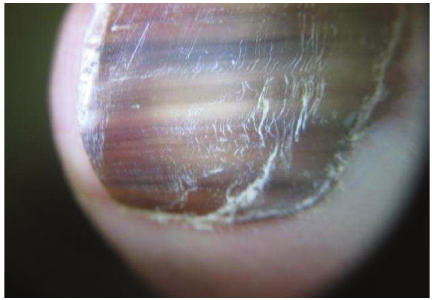
Figure 9: Dermoscopy of the nail apparatus melanoma in situ seen in Figure 7. Notice the brown coloration of the background and the presence of irregular longitudinal lines per color, spacing, thickness, and